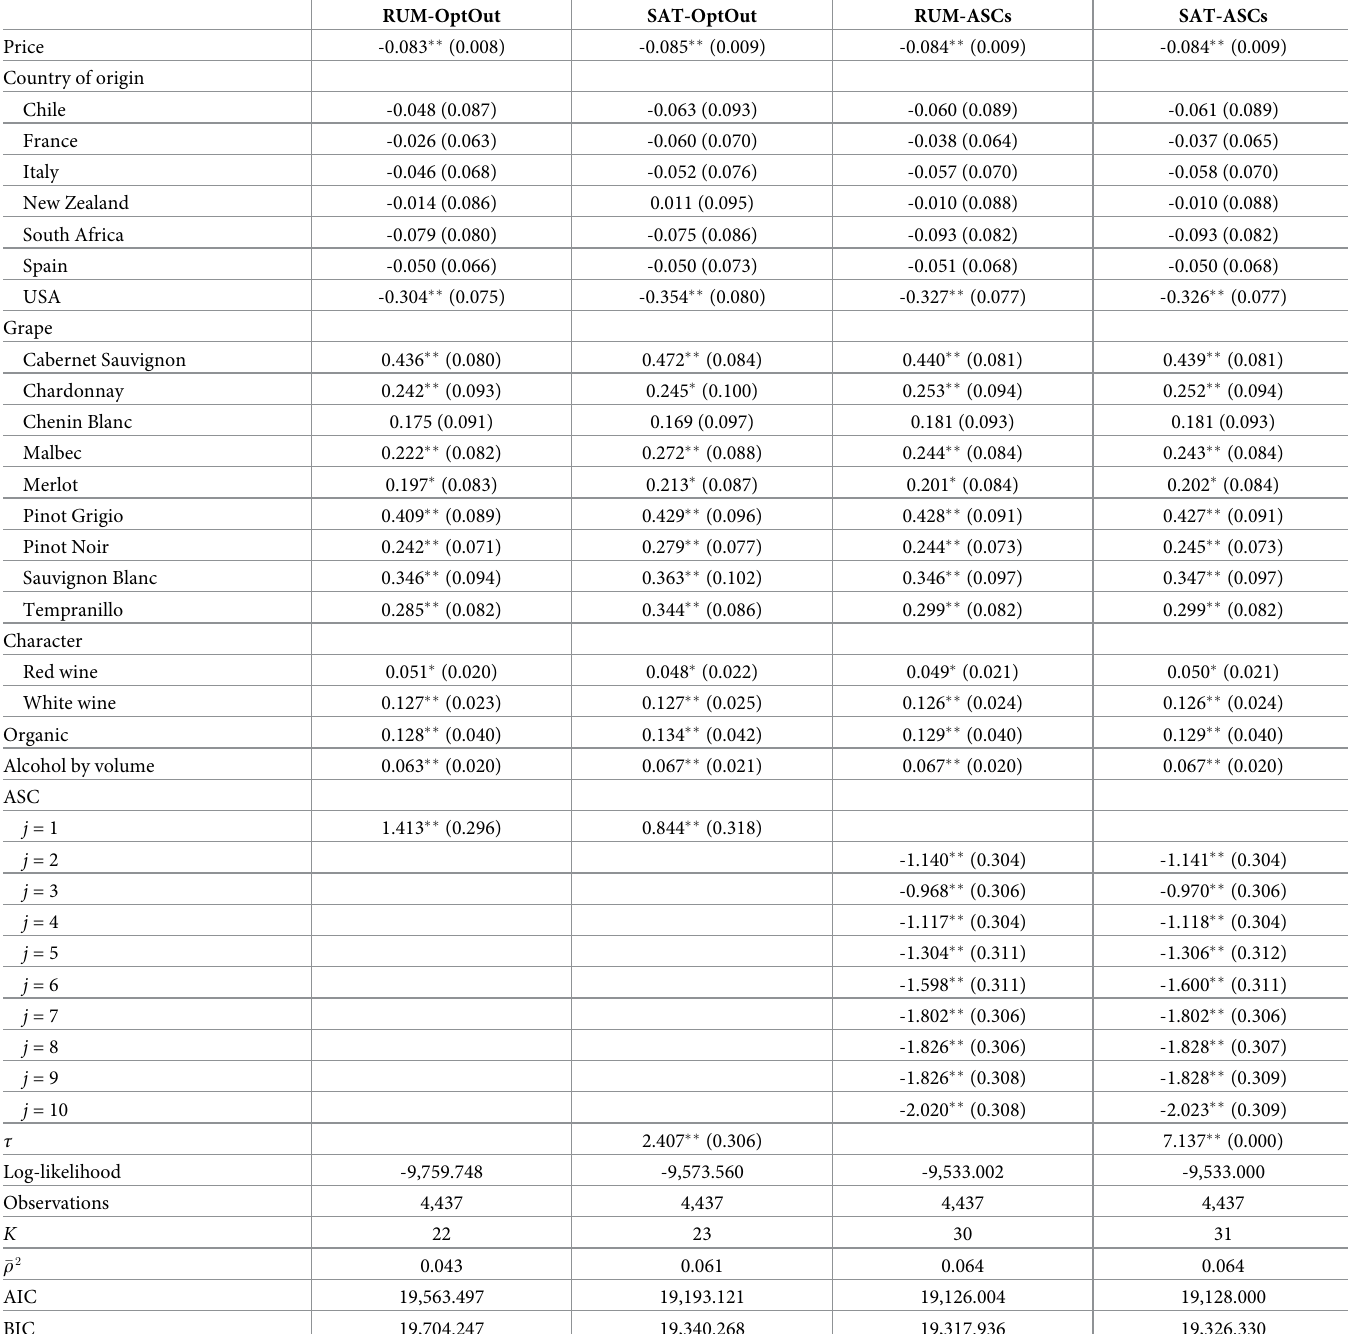
Table 6. Estimation results for treatment